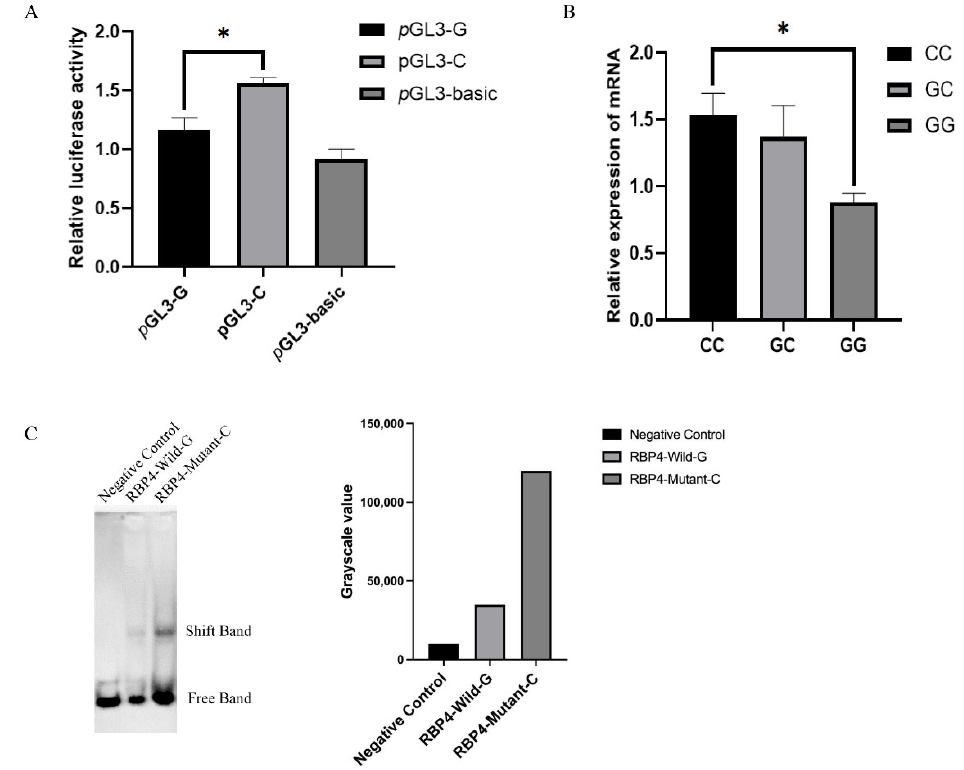
Figure 3. The g.36491960G>C mutation regulated the promoter activity of RBP4 . ( A ): The result of the dual luciferase activity assay. ( B ): Expression levels of RBP4 in different genotypes. ( C ): EMSA of RBP4 individuals with different genotypes. The results were expressed as the mean ± SEM ( n = 3). * p < 0.05.